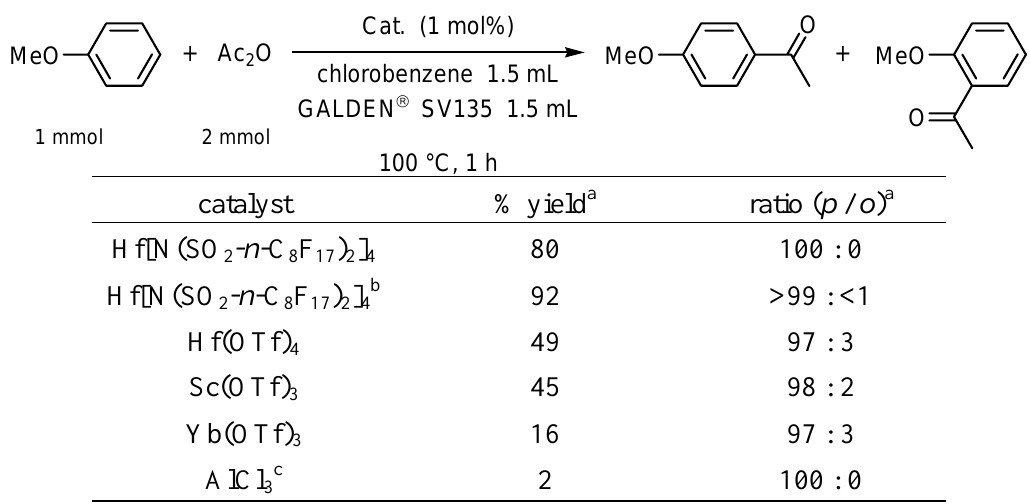
Table 2. Fluorous biphasic Friedel-Crafts